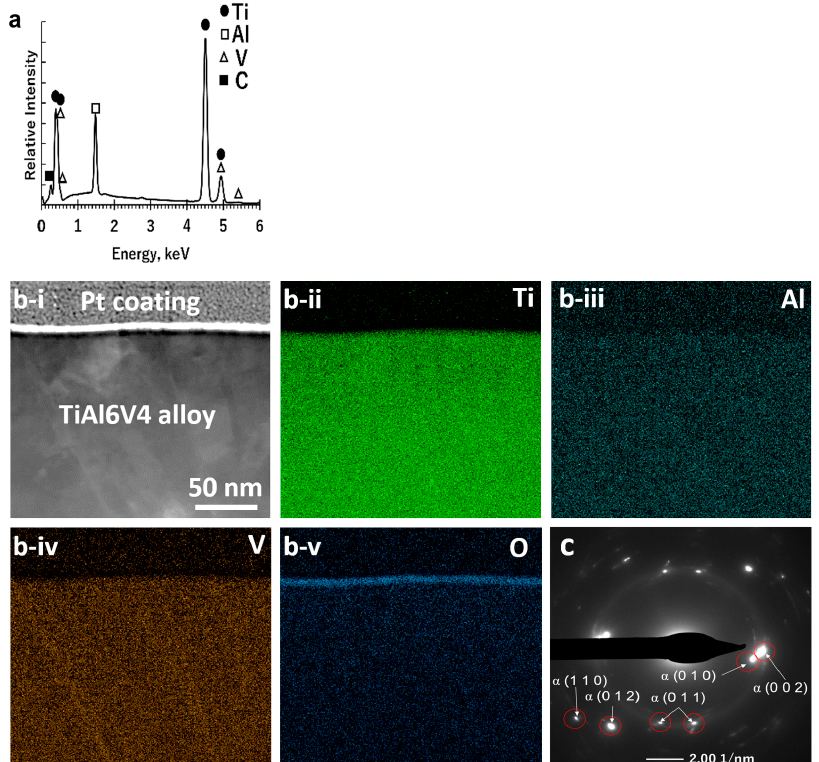
Figure 2. Characterization of a starting polished DMLS TiAl6V4 specimen: ( a ) SEM/EDX spectrum obtained from top-down analysis of the external surface; ( b-i ) cross-sectional STEM image and associ- ated EDX elemental maps for ( b-ii ) titanium, ( b-iii ) aluminium, ( b-iv ) vanadium, and ( b-v ) oxygen obtained from an ion-milled cross-section at the surface, revealing a thin Ti-O-rich surface layer; ( c ) SAED pattern, consistent with the α -TiAl6V4 phase, obtained from an ion-milled cross-section. After exposure to air for 6 h at 600 ◦ C, the alloy surface was covered with a continuous, conformal, nanocrystalline rutile TiO 2 -based layer (Figure 1b), as confirmed by